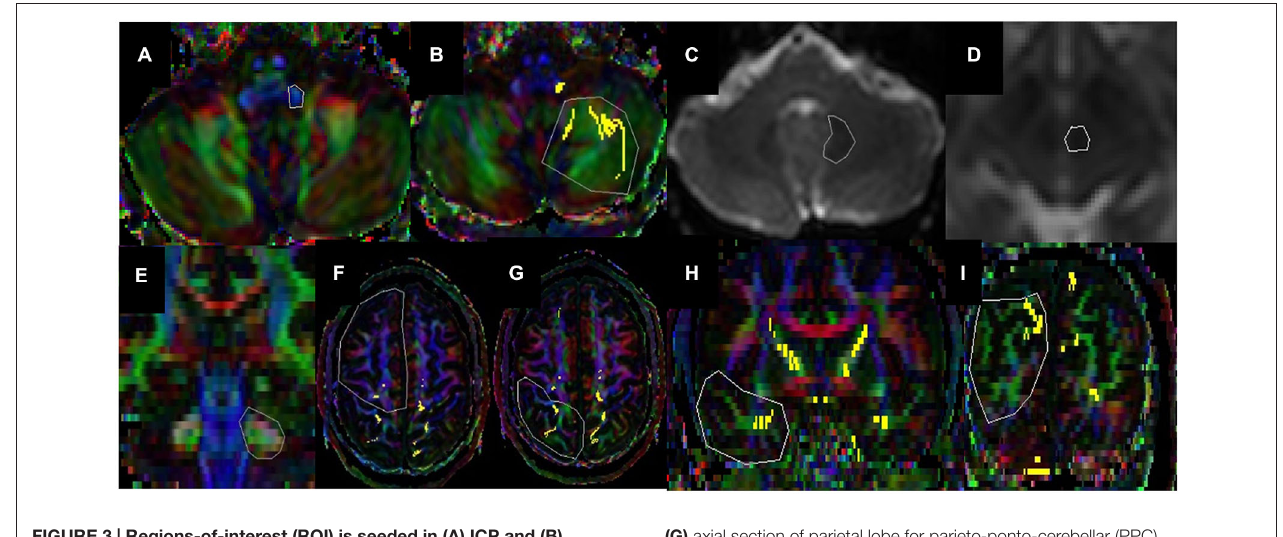
FIGURE 3 | Regions-of-interest (ROI) is seeded in (A) ICP and (B) Cerebellar Hemisphere for Spinocerebellar (SC) Tract and in (C) Dentate and (D) Red Nuclei for DRTC . Coronal section of middle cerebellar peduncle being the first ROI for (E) Cortico-Ponto-Cerebellar pathways, (F) axial section of frontal lobe for fronto-ponto-cerebellar (FPC),